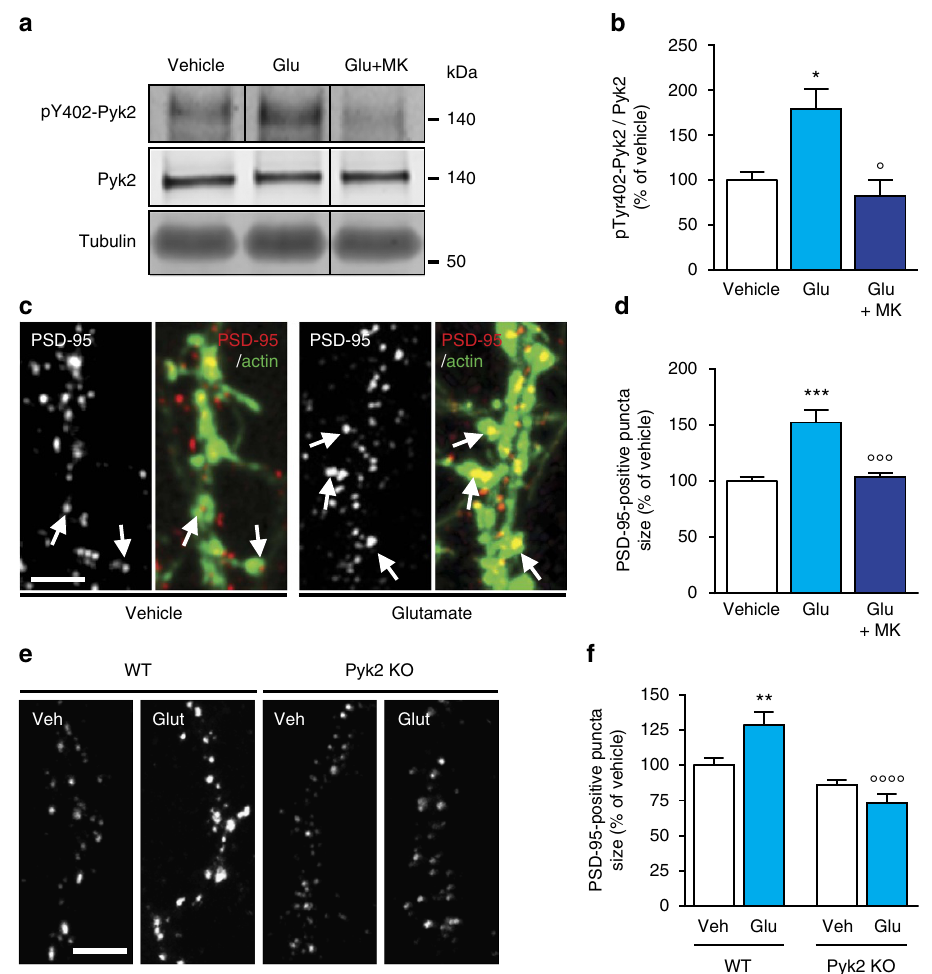
Figure 5 | Pyk2 modulates glutamate-induced PSD-95 accumulation in dendritic spines. ( a ) Hippocampal neurons were cultured for 3 weeks and treated for 15min with vehicle or glutamate (Glu, 40 m M) without or with MK801 (MK, 10 m M), added 30min before. PhosphoTyr402-Pyk2 (pY402-Pyk2), Pyk2 and a -tubulin as a loading control were analysed by immunoblotting. Molecular weight markers position is indicated in kDa. ( b ) Densitometric quantification of results as in a . One-way ANOVA ( F (2,13) ¼ 8.02, P ¼ 0.005, n ¼ 4–7 per group) and post hoc Holm-Sidak’s test for multiple